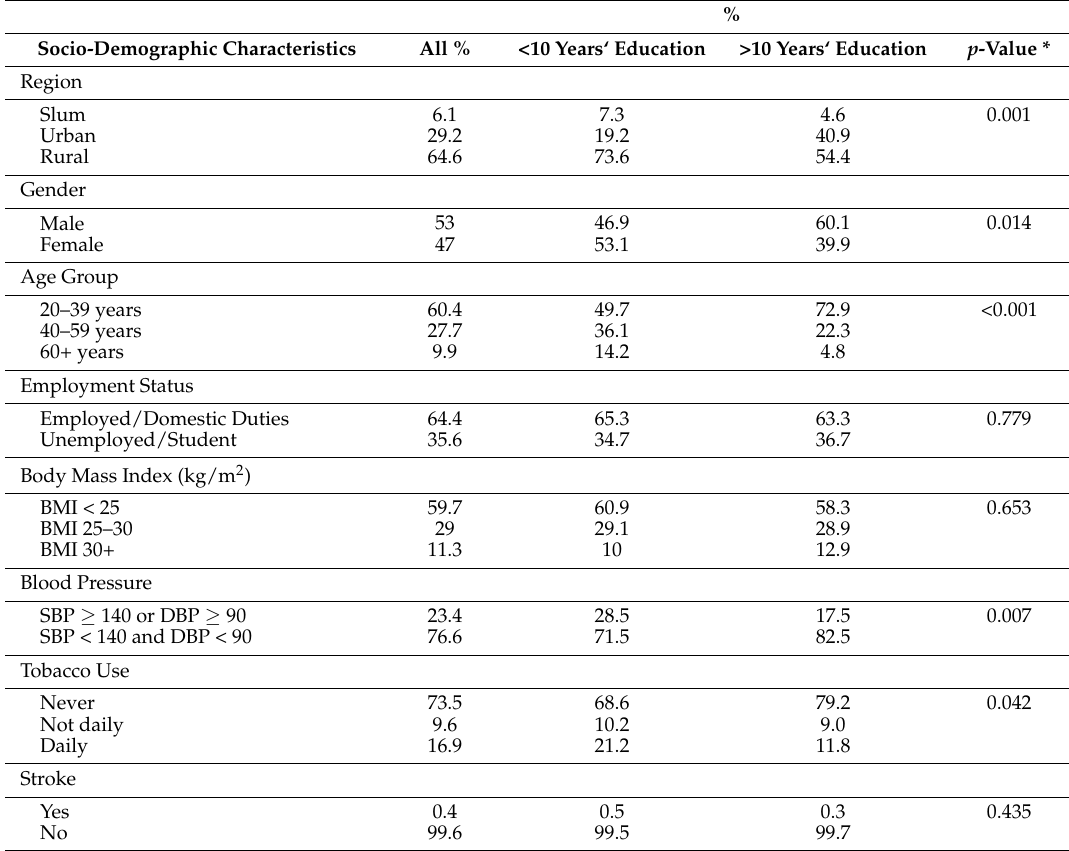
Table 1. Characteristics of population overall and by level of education ( N = 1395).